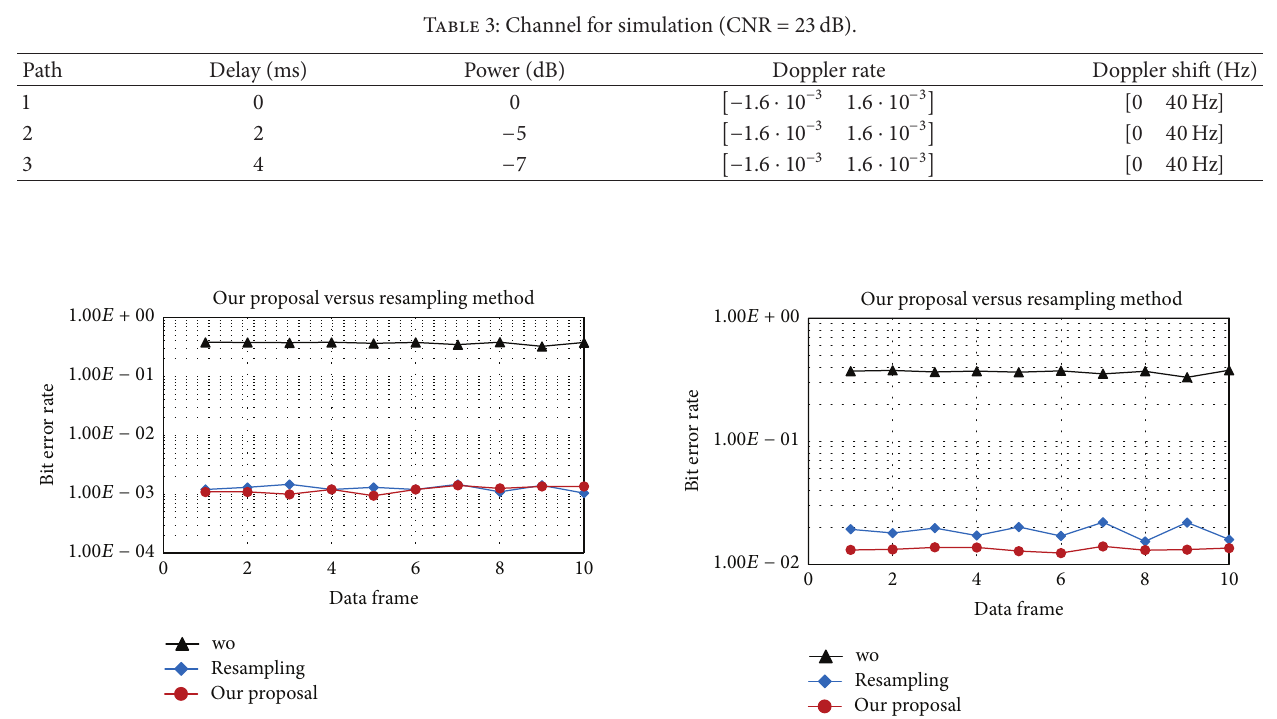
Figure 8: 64QAM, proposed method versus the resampling based method.